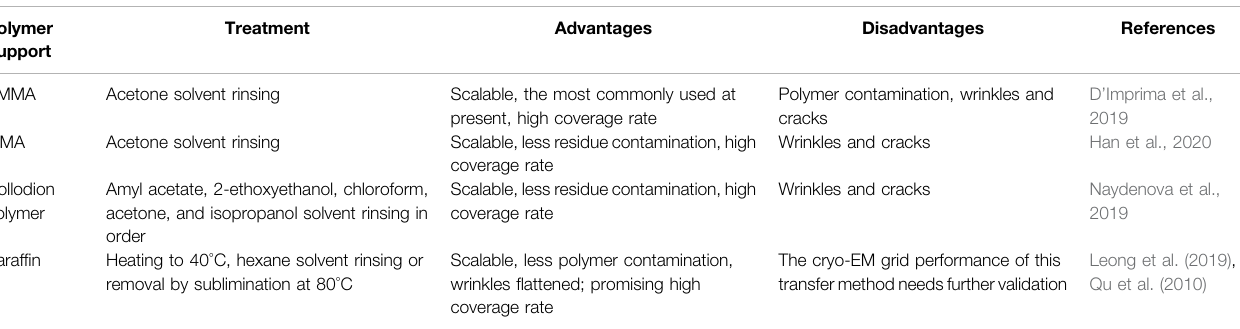
TABLE 1 | Polymer-assisted transfer methods for fabricating graphene